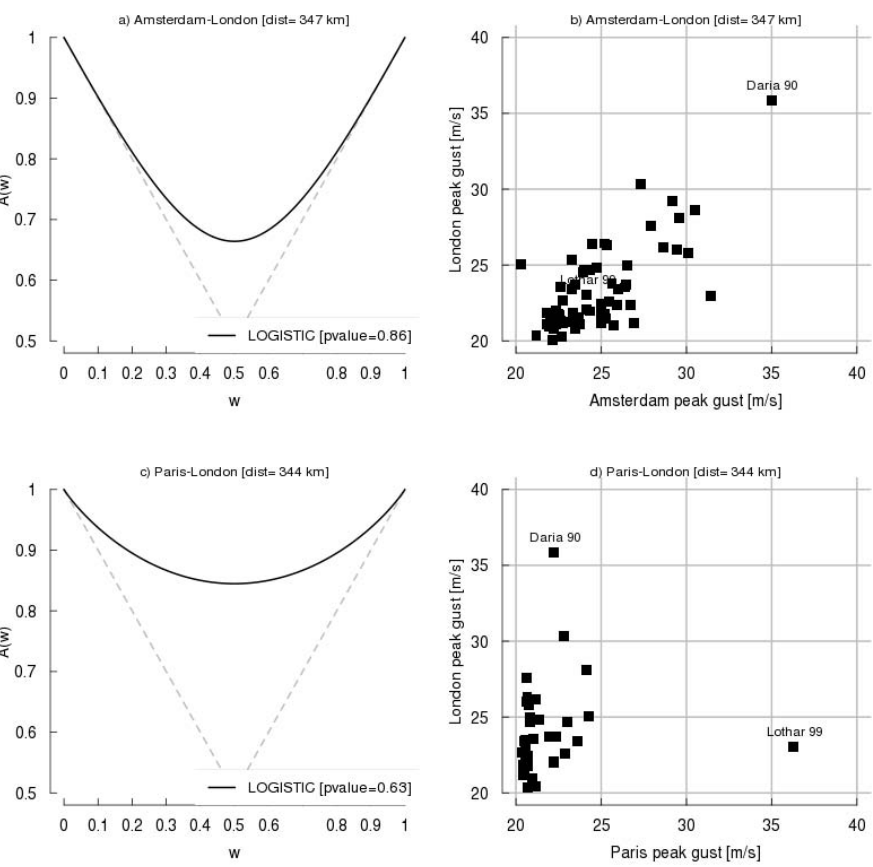
Fig. 3. Pickands functions and scatter plots of [ 3]s peak gust from historical reconstruction footprints for location pairs London-Amsterdam and